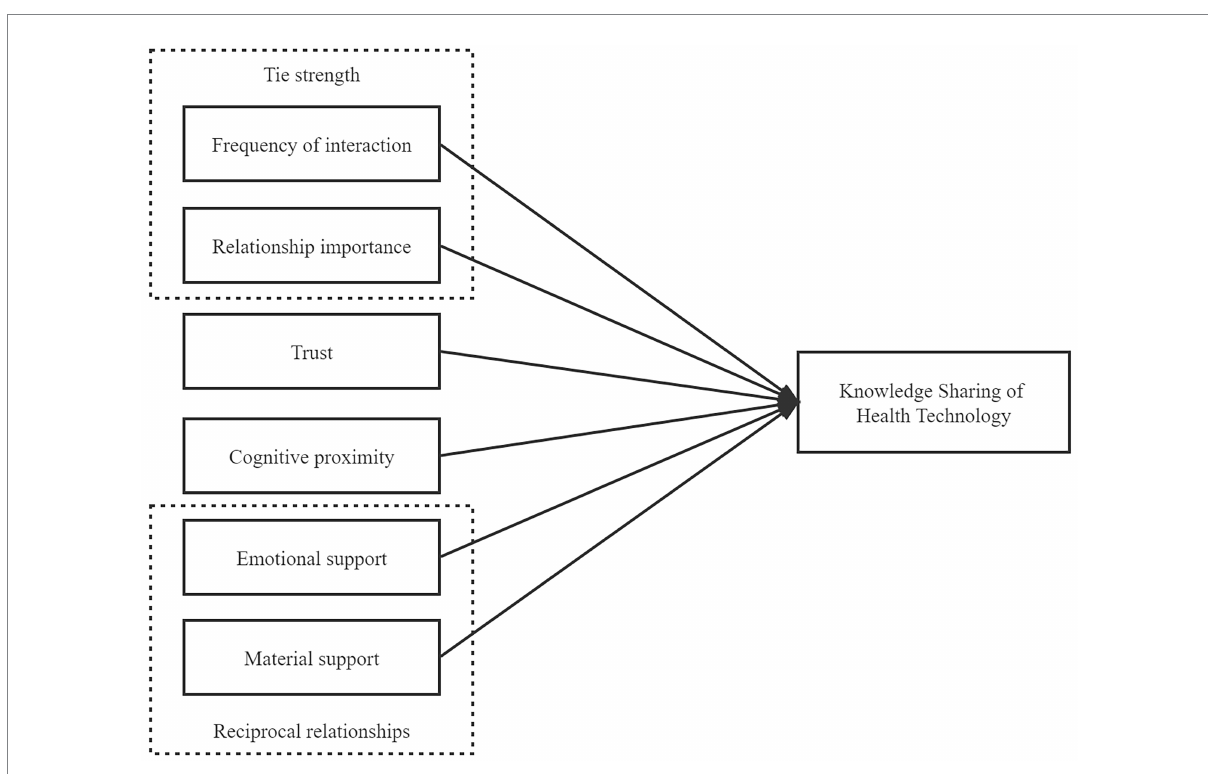
FIGURE 1 Theoretical framework of knowledge sharing of health